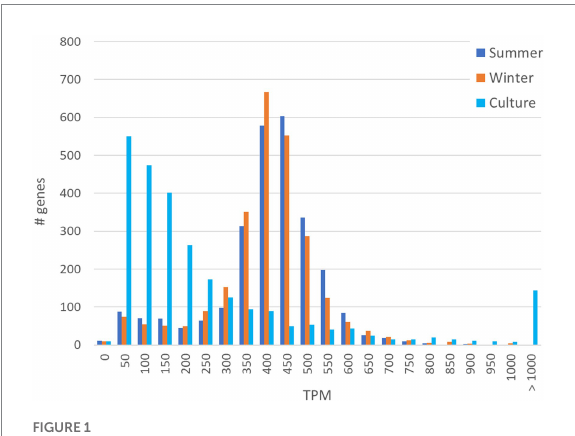
FIGURE 1 Histogram of TPM distribution and number of genes involved in the two metatranscriptomes (summer and winter) in comparison to the transcriptome of the cultivated isolate Hqr. Walsbyi